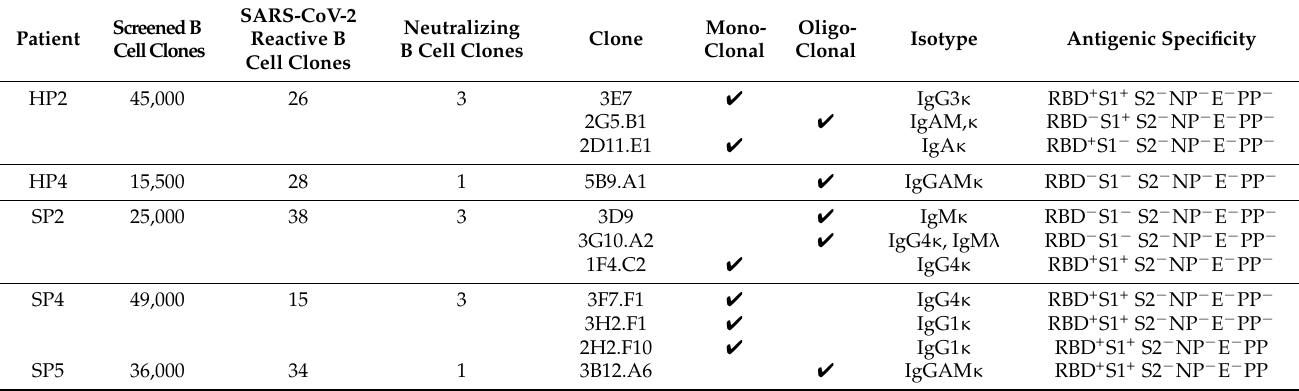
Table 2. Protective B cell clones isolated from convalescent